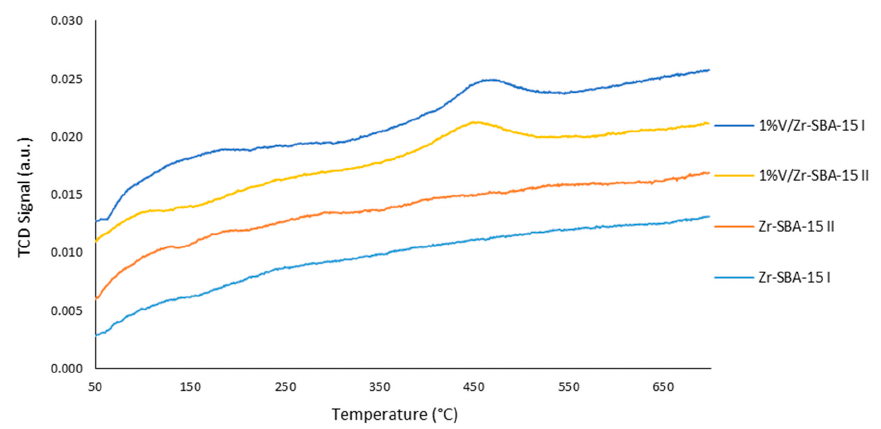
Figure 7. H2-TPR patterns for all catalysts. Figure 7. H2 ‐ TPR patterns for all catalysts. Table 4. Properties of acid sites determined by NH3 ‐ TPD. LT—low temperature sites; HT—high temperature sites.